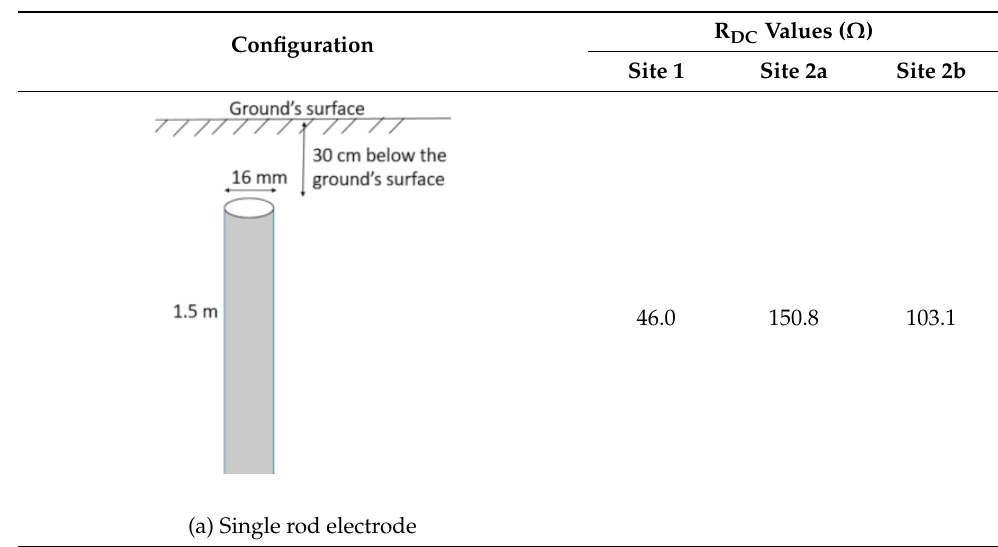
Table 2. Configurations of ground electrodes and their corresponding R DC